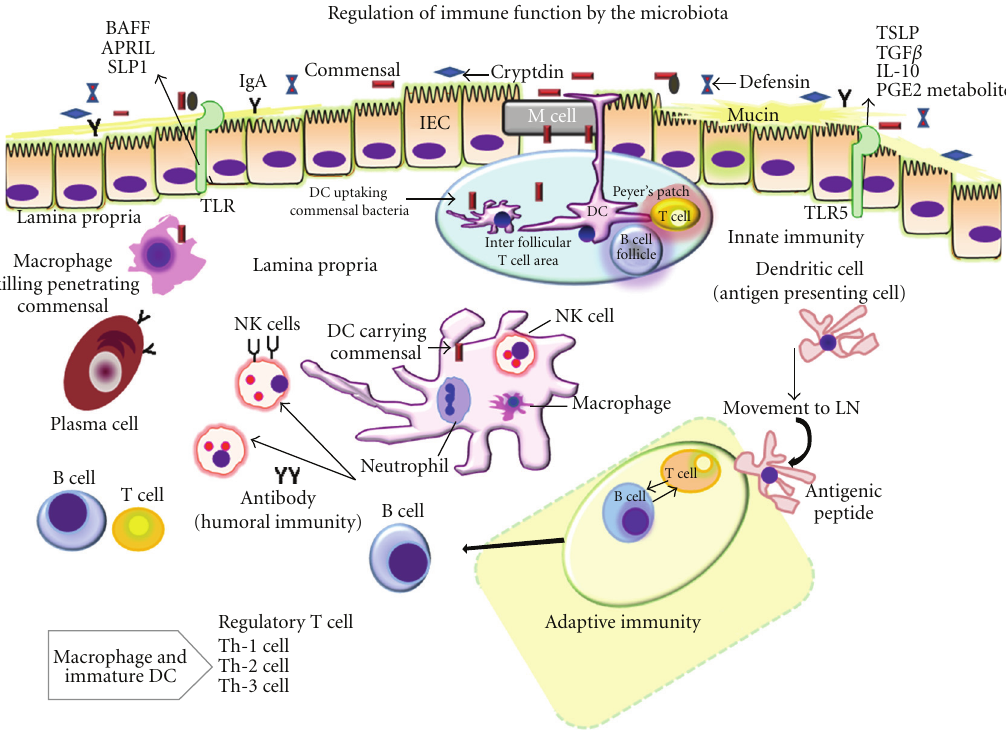
Figure 6: Influenced by the microbiota, intestinal epithelial cells (IECs) elaborate cytokines, including thymic stromal lymphoprotein (TSLP), transforming growth factor (TGF), and interleukin-10 (IL-10), that can influence pro-inflammatory cytokine production by dendritic cells (DC) and macrophages present in the lamina propria (GALT) and Peyer’s patches. Signals from commensal organisms may influence tissue-specific functions, resulting in T-cell expansion and regulation of the numbers of Th-1, Th-2, and Th-3 cells. Also modulated by the microbiota, other IEC derived factors, including APRIL (a proliferation-inducing ligand), B-cell activating factor (BAFF), secretory leucocyte peptidase inhibitor (SLPI), prostaglandin E 2 (PGE 2 ), and other metabolites, directly regulate functions of both antigen presenting cells and lymphocytes in the intestinal ecosystem. NK: natural killer cell; LN: lymph node; DC: dendritic cells. (Modified from Sharma R, Young C, Mshvildadze M, Neu J. Intestinal Microbiota Does It Play a Role in Diseases of the Neonate? NeoReviews Vol.10 No.4 2009 e166 , with